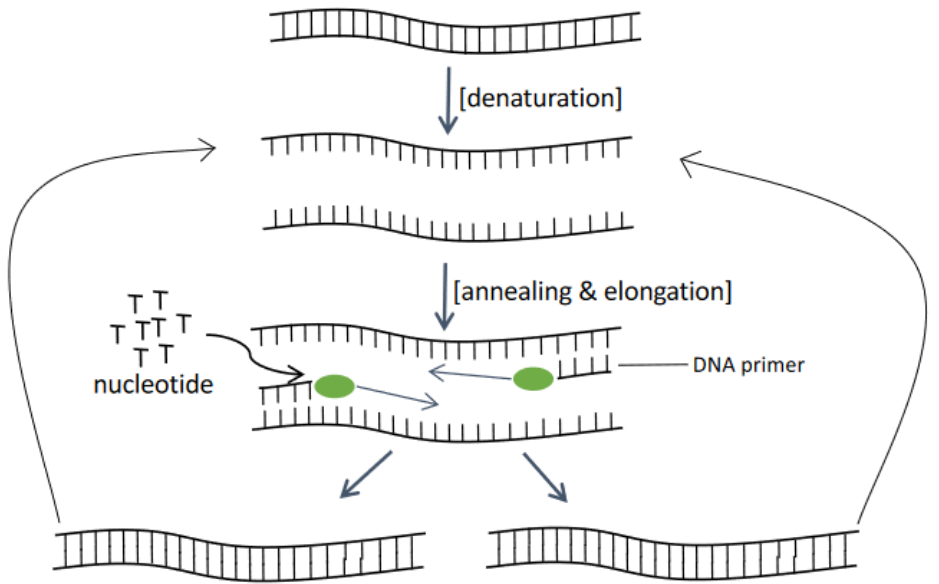
Figure 4. General concept of PCR.